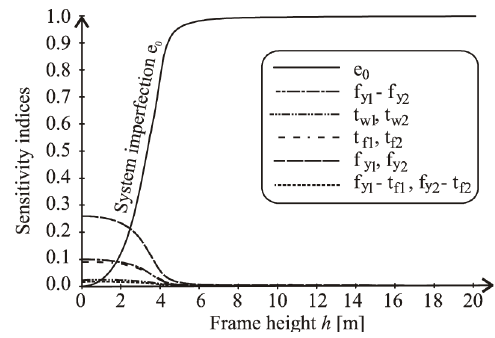
Fig. 11. Sensitivity analysis – Frame 2